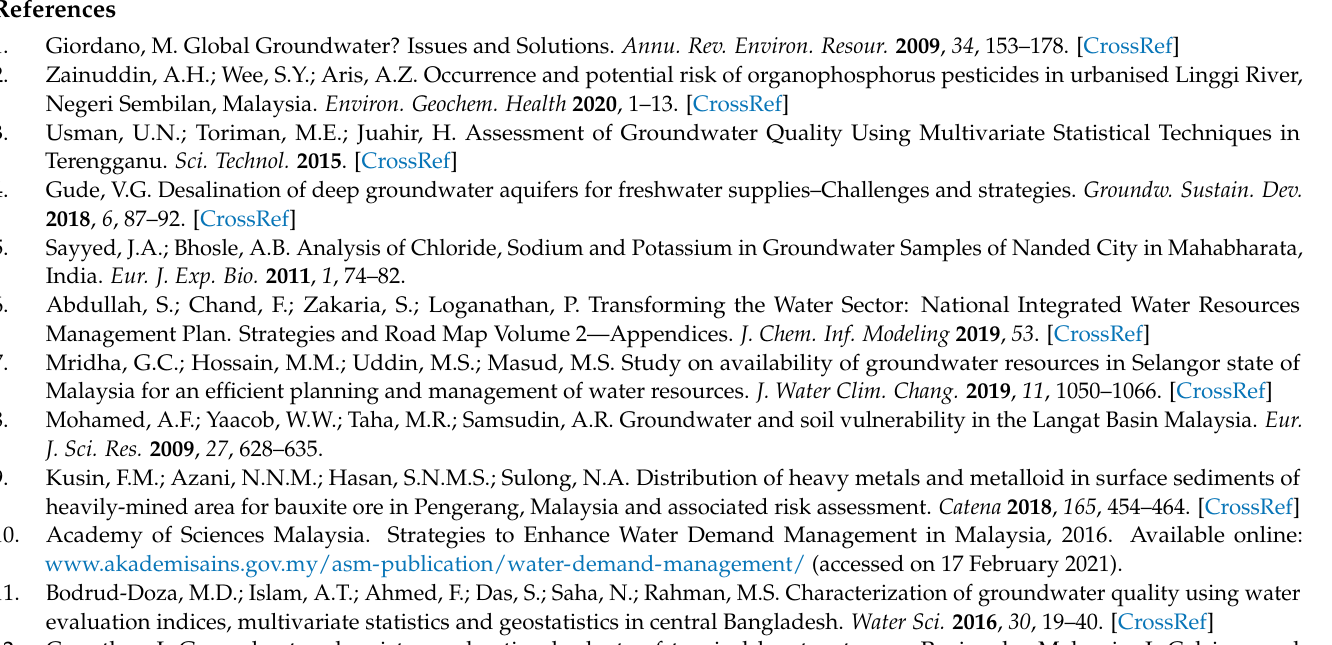
descriptive analysis., Table S3. Heavy metals descriptive analysis. Figure S1. Major ions concentration distribution along with sampling